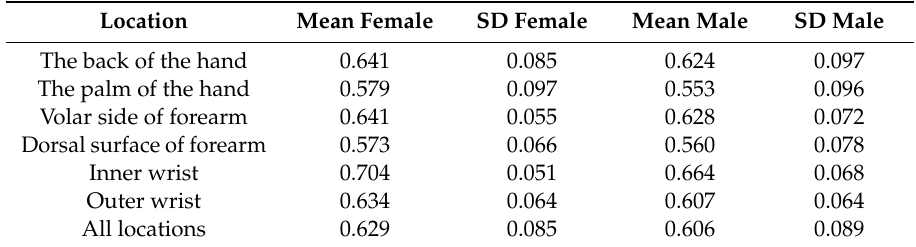
Table 2 indicates di ff erences in the mean reflectance values between female and male groups.